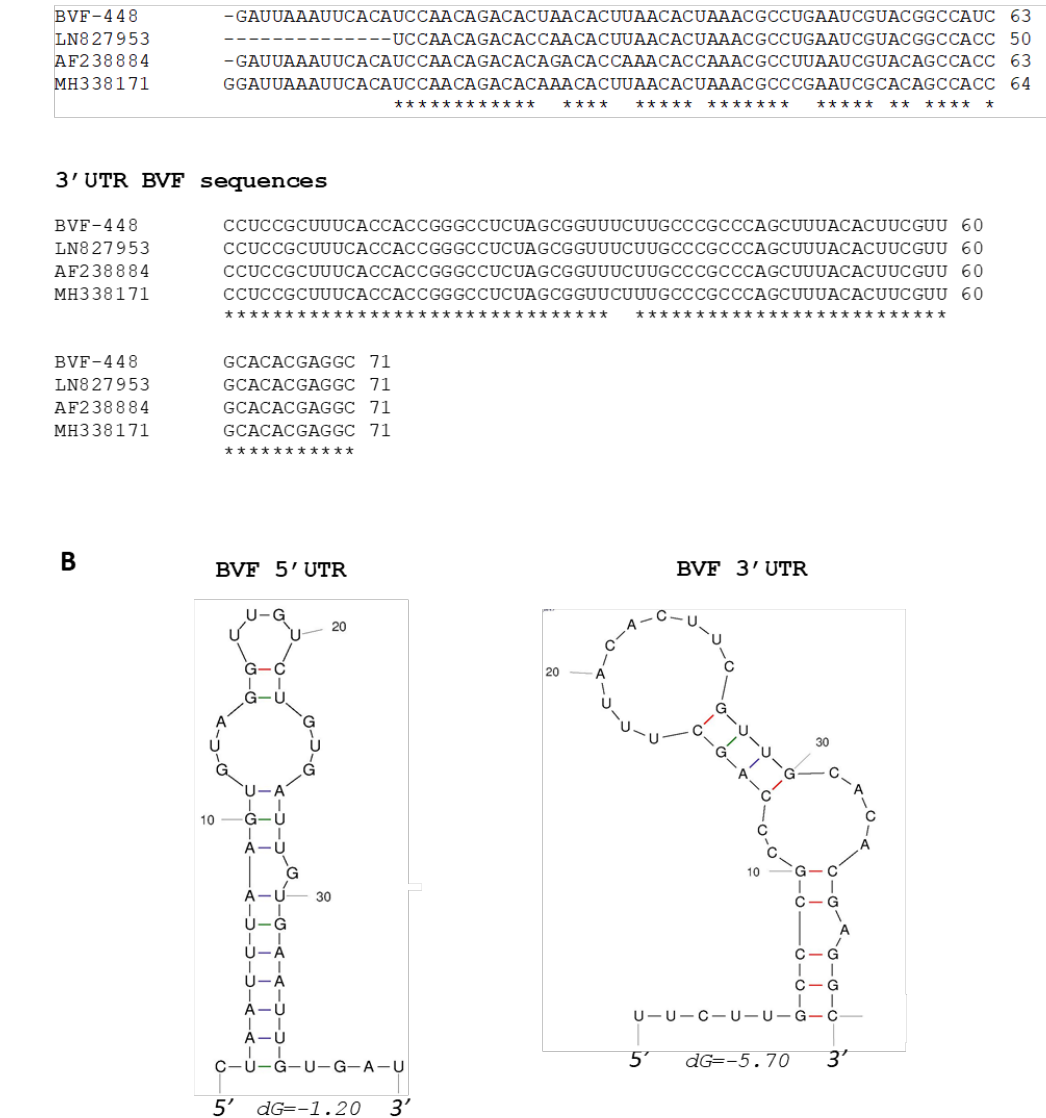
Figure 1. Analysis of 5′ and 3′ UTR sequences of BVF. ( A ) Comparison of sequences in the 5′ UTR and 3′ UTR of different BVF strains; ( B ) Predicted secondary structures of the first 40 nucleotides of the negative strand of 5′ UTR and the last 40 nucleotides of the positive strand of 3′ UTR. Complete sequence of full-length BVF-V448 cloned in this work was determined by primer walking (GenBank Accession number OM928008). The sequence of BVF-V448 was 6827 nt in length and showed identity values of 92%, 87% and 84% to BVF strains